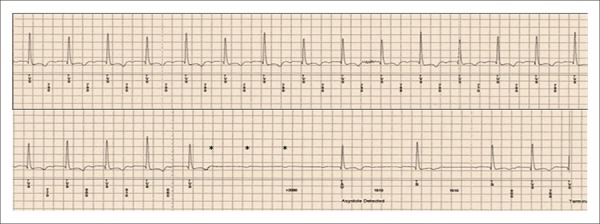
Recording of an advanced atrioventricular block episode by the implantable loop
recorder. The marks (*) show three blocked P waves, indicating a
pause of 3.1 s.